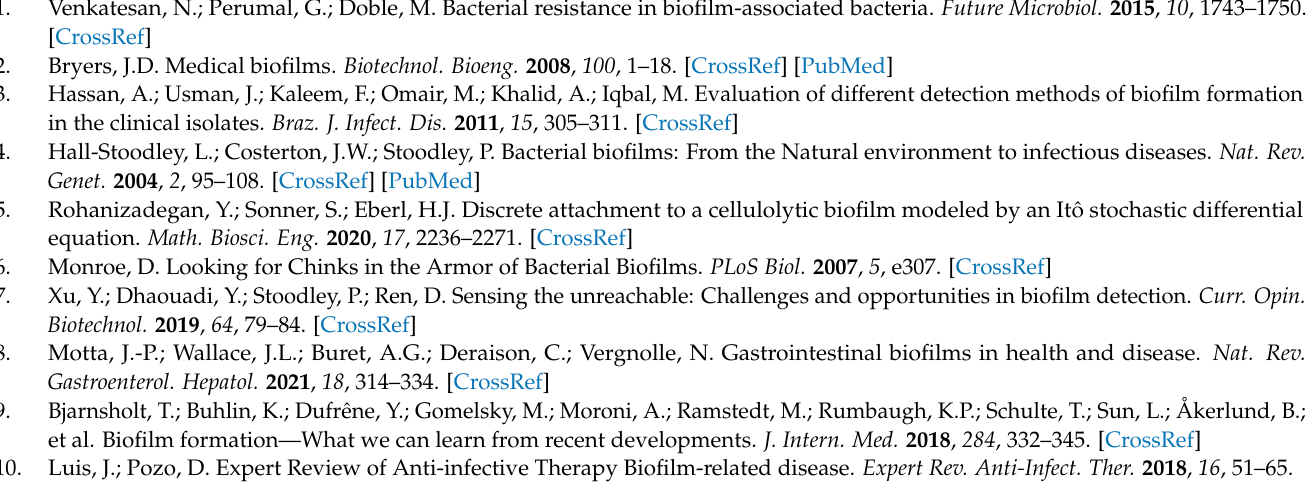
laser. Figure S2. Settings of ball resonators manufacture: (a) Physical characteristics settings; (b) Heating settings; (c) Rotation settings; (d) Movement settings; (e) Measurements of fabricated ball resonators. Figure S3. View of all response of all experiments over time. Figure S4. Scanning electron microscopy of OD = 0.5 sample. The yields of initial attachments of bacteria are seen. Figure S5. Spectra of ball resonators: (a–c) ball resonators used for OD = 0.05 experiment with di- ameters 535–541 µ m, 541–534 µ m, 526–521 µ m, respectively; (d–f) ball resonators used for OD = 0.1 experiment with diameters 569–561 µ m, 544–538 µ m, 543–539 µ m, respectively; (g–i) ball resonators used for OD = 0.05 experiment with diameters 532–523 µ m, 523–521 µ m, 520–513 µ m, respectively. Figure 6. Spectra of ball resonators used for controls: (a–c) ball resonators used for control DC with diameters 565–559 µ m, 567–564 µ m, 571–564 µ m, respectively; (d–f) ball resonators used for control NB with diameters 568–561 µ m, 569–563 µ m, 570–564 µ m, respectively. Table S1. Size and sensitivity of all BRs used in experiments (NB—nutrient broth, DC—dead cells, bacteria OD = 0.5, OD = 0.1, OD =